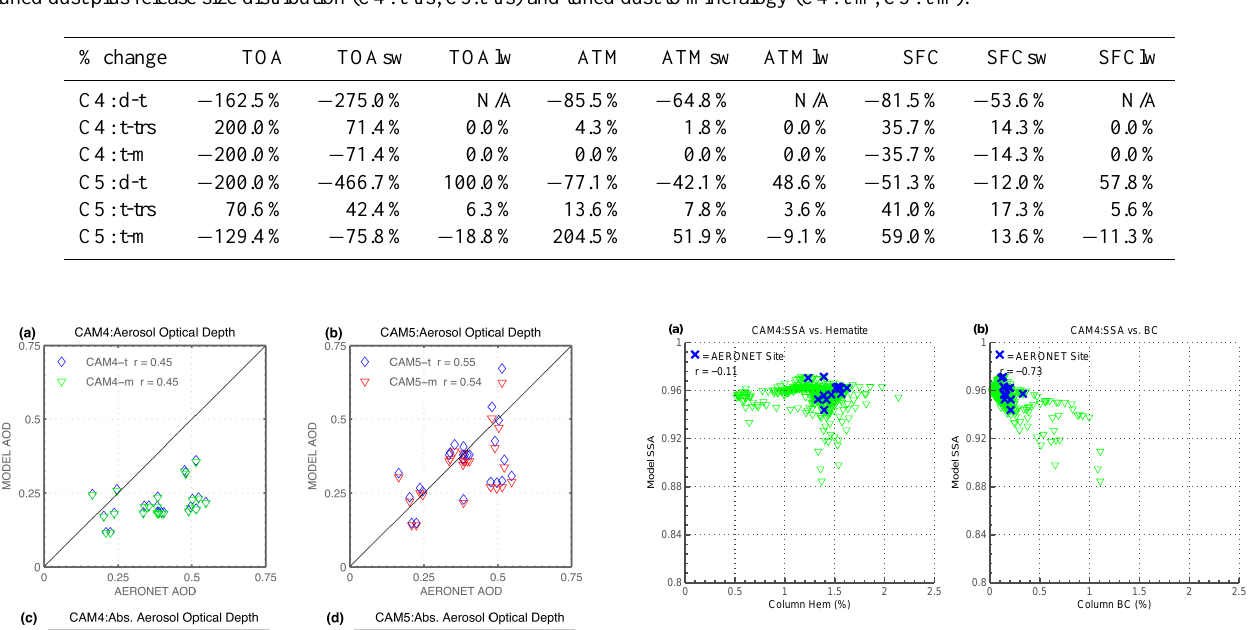
Table 9. Percent change in annual all-sky radiative forcing for CAM4 and CAM5 from default to tuned dust (C4:d-t, C5:d-t), tuned dust to tuned dust plus release size distribution (C4:t-trs, C5:t-trs) and tuned dust to mineralogy (C4:t-m, C5:t-m).